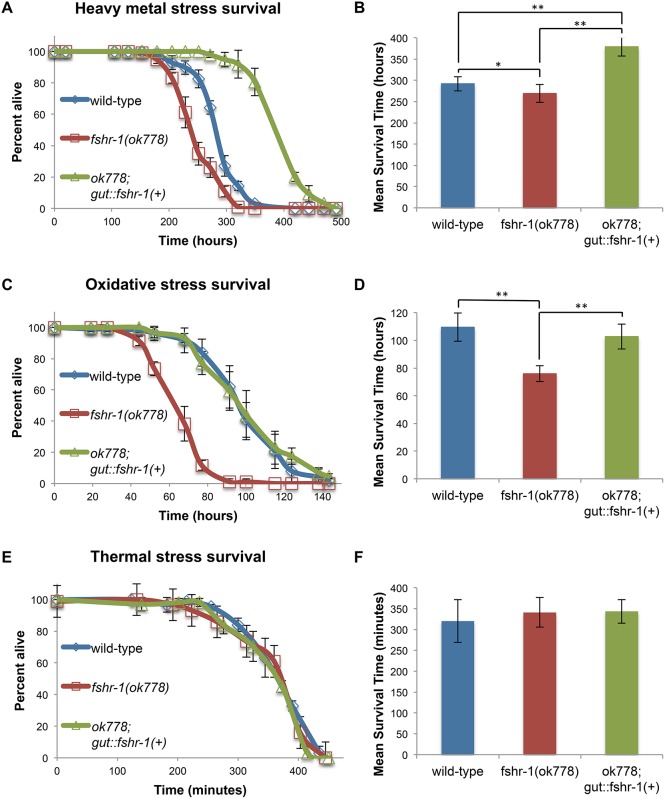
FSHR-1 is required for the survival of heavy metal and oxidative stress.Wild-type, fshr-1(ok778) mutants, and mutants rescued with fshr-1(+) in the intestine were measured for their ability to survive different types of stress. Worms were subjected to 100 μM cadmium (A, B), 5 mM paraquat (C, D), or 37°C (E, F). Representative survival curves for approximately 80–100 worms for each condition are shown in (A, C, and E) with standard deviation error bars. The mean survival time for each genotype was calculated for at least three independent experiments (B, D, F). Error bars are SEM. One-way ANOVA and Tukey HSD test, *P<0.05, **P<0.01.